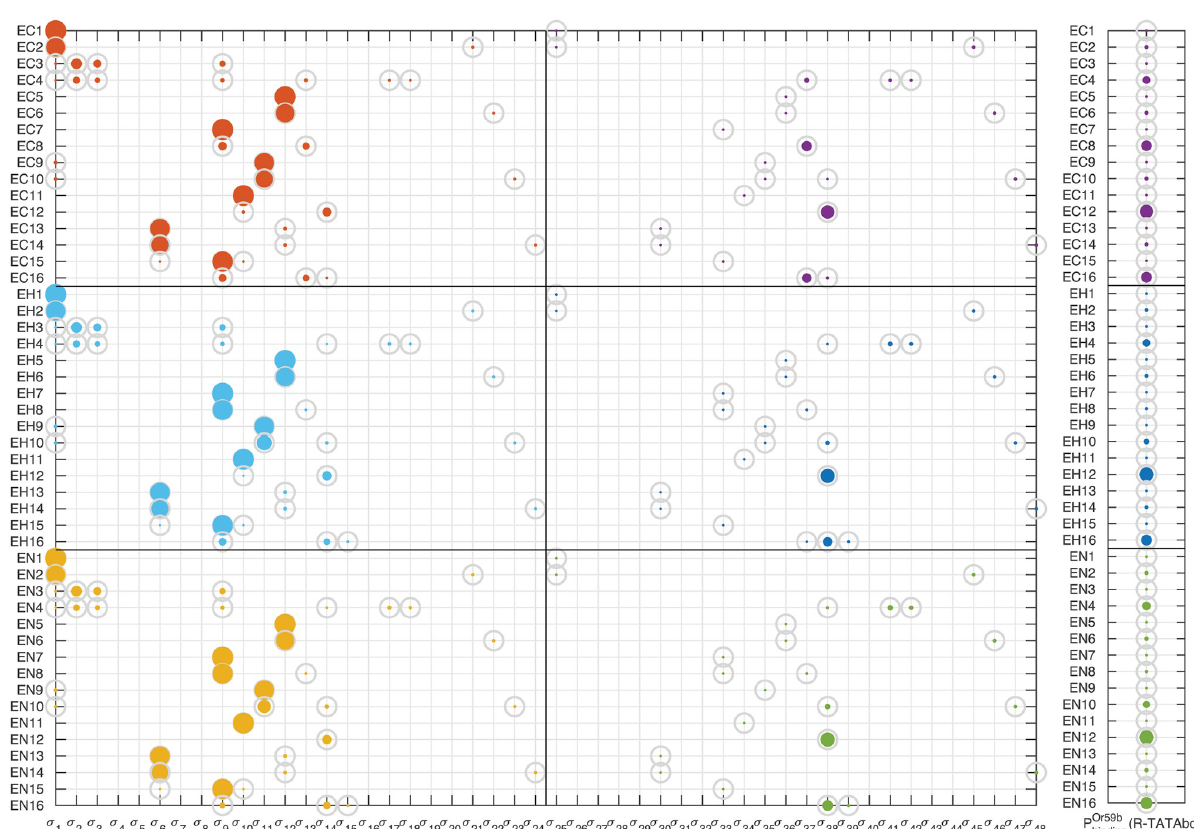
Fig 3. Statistical weights of the σ configurations for one sample. Normalized statistical weights P ( σ k (horizontal axis) for the 16 × 3 mutations of the truth table (vertical axis) in one choice of parameter values that fits all the interval constraints of the truth table (Table 1). For each row the weights P ( σ k ) must sum to 1. The size of a dot is proportional to the weight. The gray circles correspond to the unity. The left (resp. right) half of the table corresponds to states for which RNAp is not (resp. is) bound to the TATAbox, see Figs. A-B of S1 Text. ð R (cid:0) TATAbox Þ (i.e., sum of the right half of the table) is represented in the rightmost P Or 59 b binding